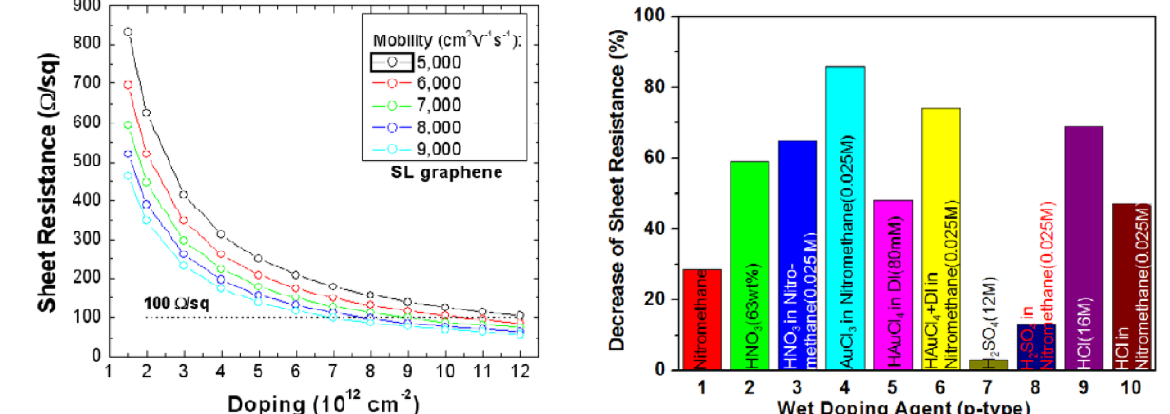
Figure 13. Calculated sheet resistance of a graphene film as a function of doping density with different charge carrier mobility is shown on the left. The decrease in sheet resistance using various wet doping agents is shown on the right. Reprinted with permission from [23]. Copyright (2010) by the Macmillan Publishers